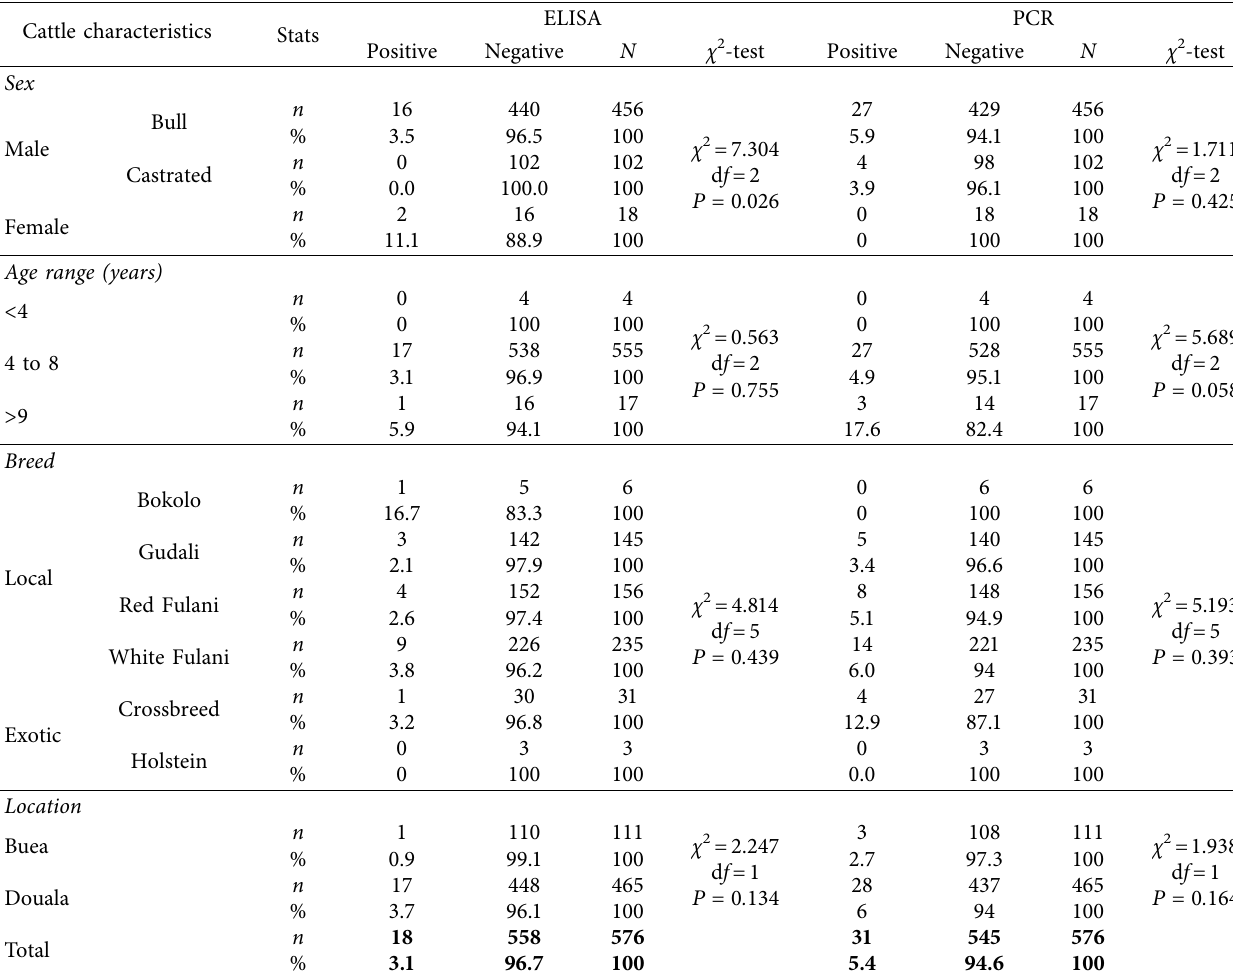
Table 3: Prevalence of cattle brucellosis in cattle slaughtered at the Douala and Buea slaughterhouses based on ELISA and PCR results layered by animal characteristics. Cattle